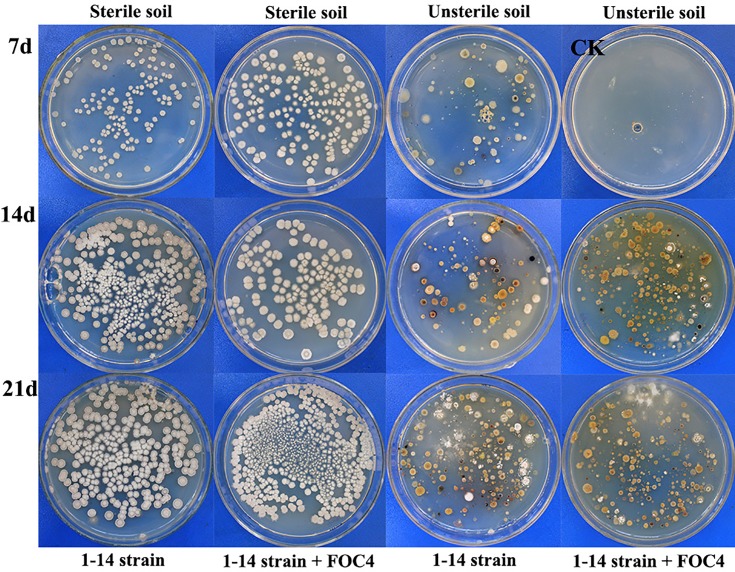
The colonization of antagonistic Streptomycetes sp. 1–14 in sterilized and unsterilized soils.